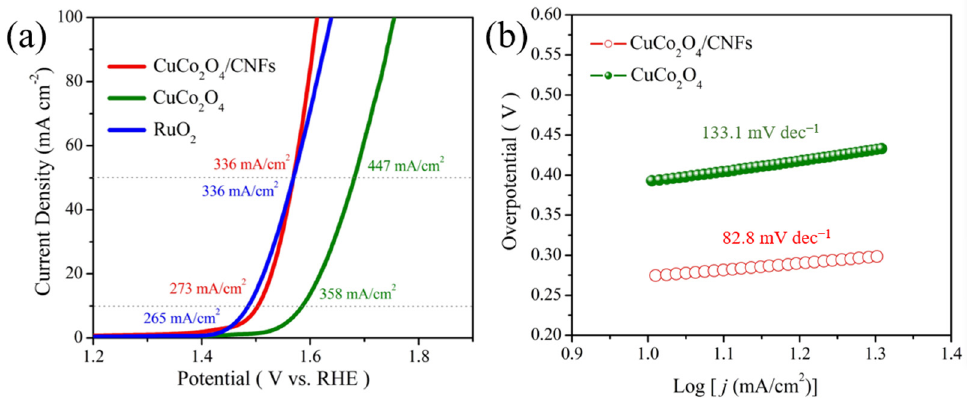
Figure 6. ( a ) OER polarization curves of RuO 2 , CuCo 2 O 4 @CNFs, and CuCo 2 O 4 at a scan rate of 5 mV